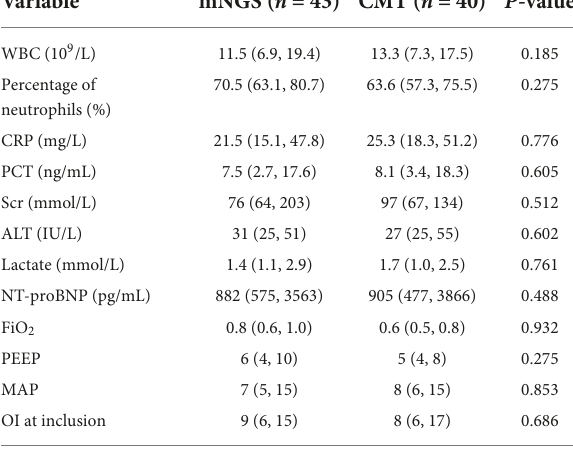
TABLE 2 Laboratory data and ventilator parameters during the study period a